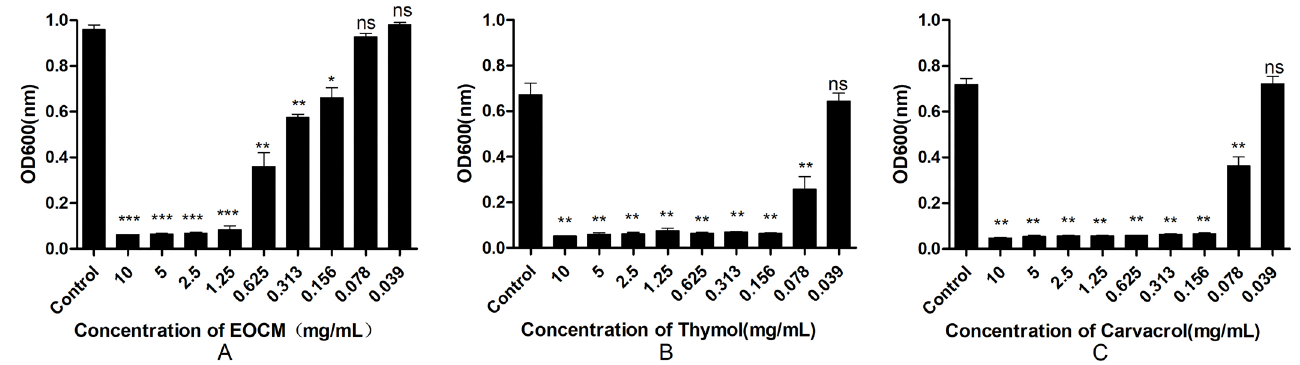
Figure 6. Effect of EOCM ( A ), thymol ( B ) and carvacrol ( C ) on the growth of biofilm. Error bars represent the standard deviations (SD) of the means from three biological replicates ( n = 3) in an individual experiment. ***, results were significantly different from those of control by a t test ( p < 0.001). **, results were significantly different from those of control by a t test ( p < 0.01). *, results were significantly different from those of control by a t test ( p < 0.05). ns, results were no significantly different from those of control by a t test ( p > 0.05).